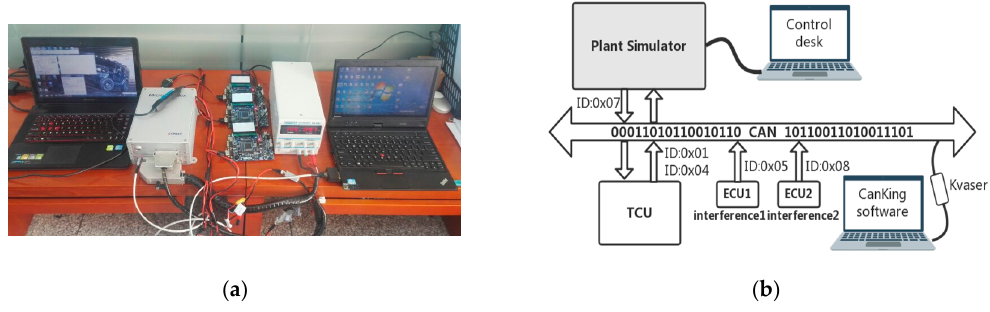
Figure 11. Hardware-In-the-Loop (HIL) test system. ( a ) A real CAN-based test system; and ( b ) Schematic diagram of the test system. ECU: electronic control unit.